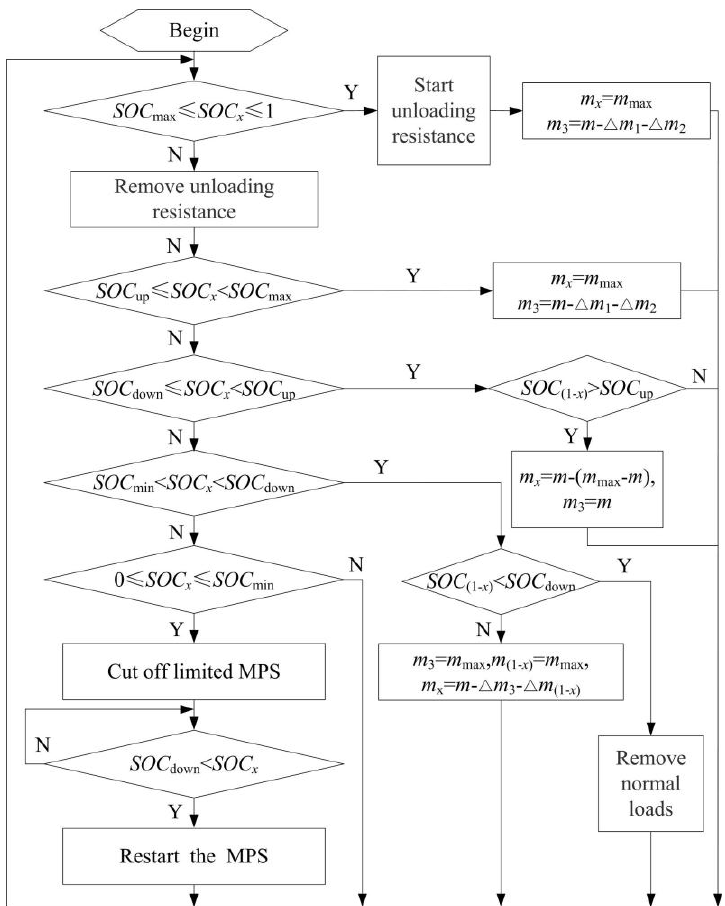
Figure 8. Block diagram of the scheduling strategy of the islanded series micro-grids